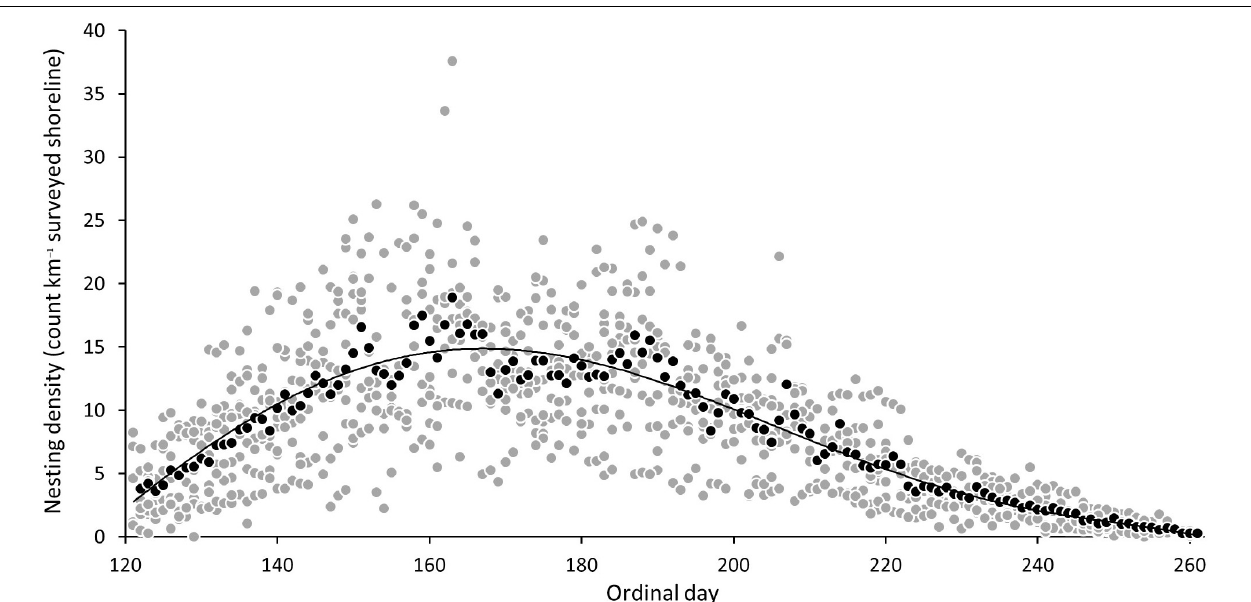
FIGURE 7 | Mean daily nesting density (gray circle) and mean of nesting density of ordinal dates across all years (black circle) and sixth degree polynomial trend line (6th order) of mean daily nesting densities for index beaches on Masirah (2008–2016).